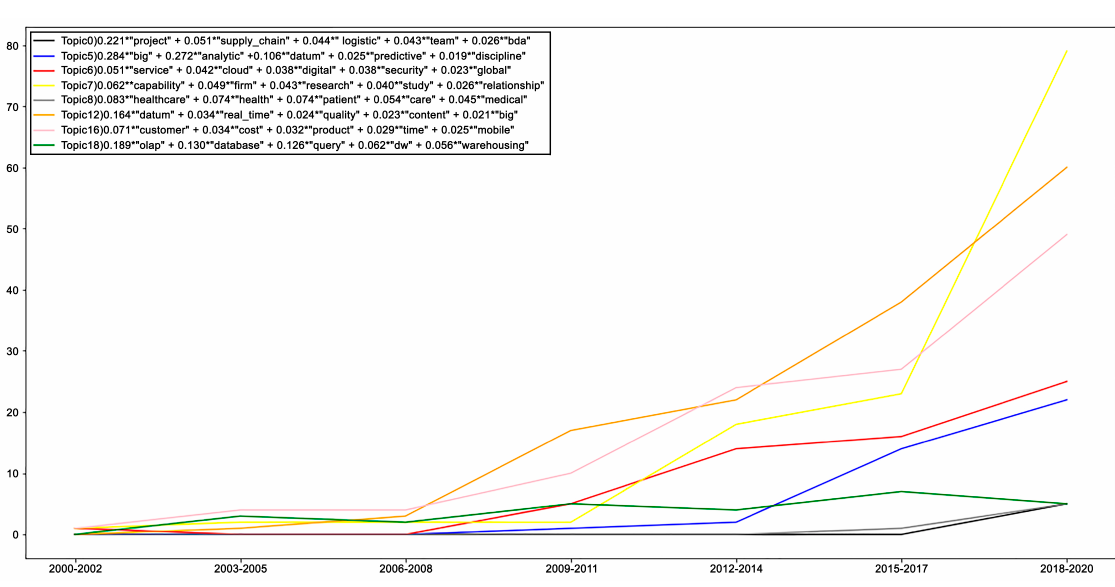
Figure 15. Keyword overlay map.